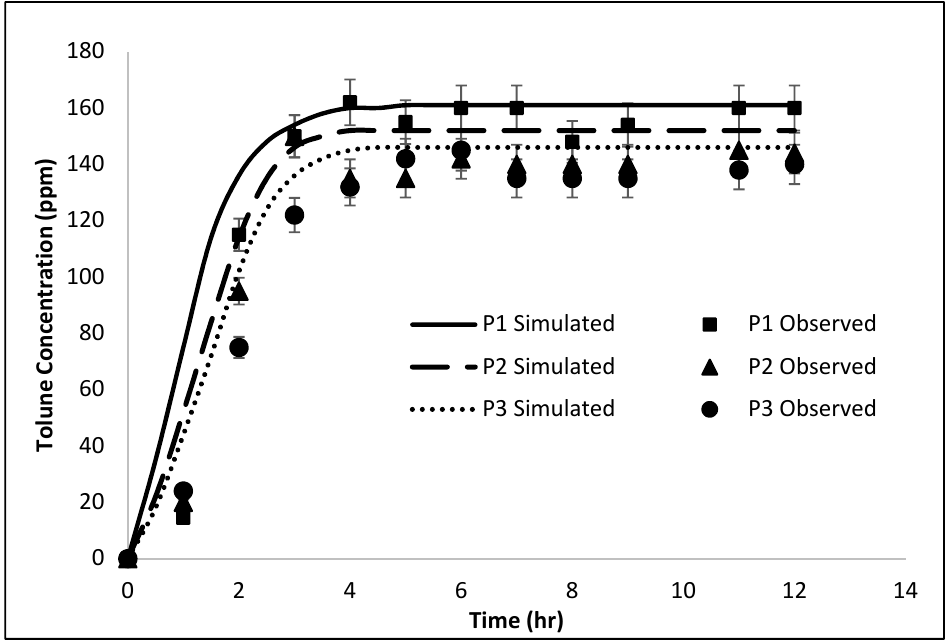
Figure 2. Concentration of NAPL at sampling port P1 (10 cm depth), P2 (20 cm depth), and P3 (30 cm depth) of column setup observed at soil-water temperature of 36 °C.